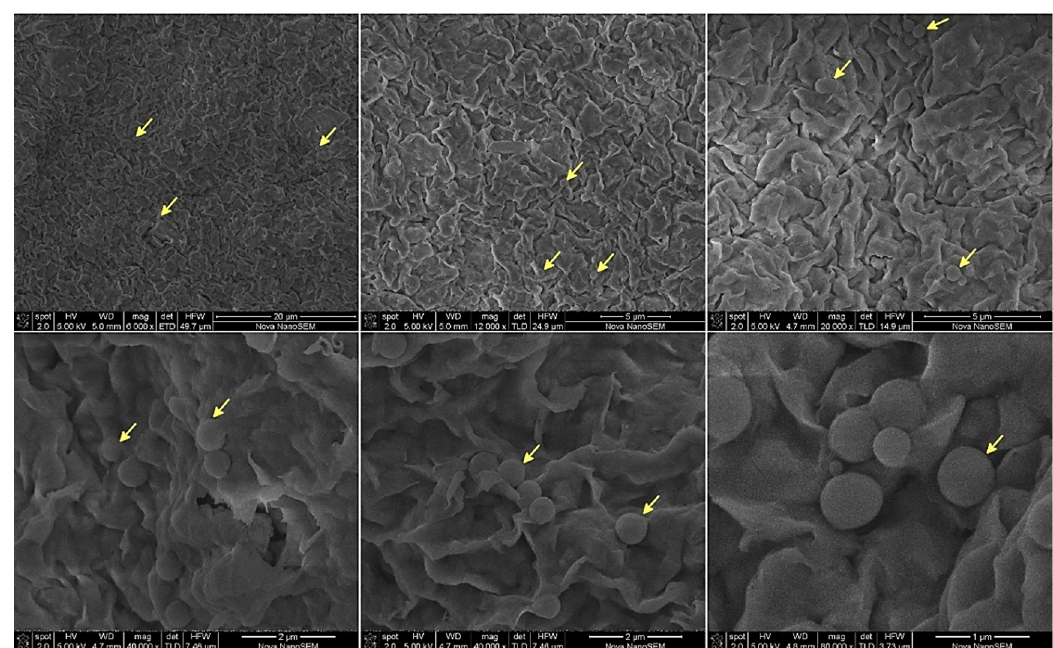
Figure 8. Scanning electron microscopy images of the initial adherence of microorganisms to the reference clay montmo- rillonite. The arrows indicate some scattered bacterial cells found over the clay.